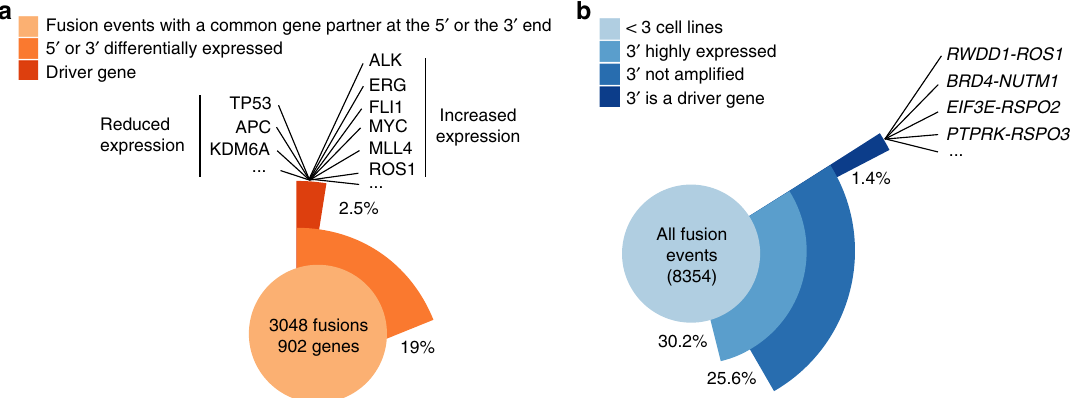
Fusion events with a common gene partner at the 5 ′ or the 3 ′ end 5 ′ or 3 ′ differentially expressed